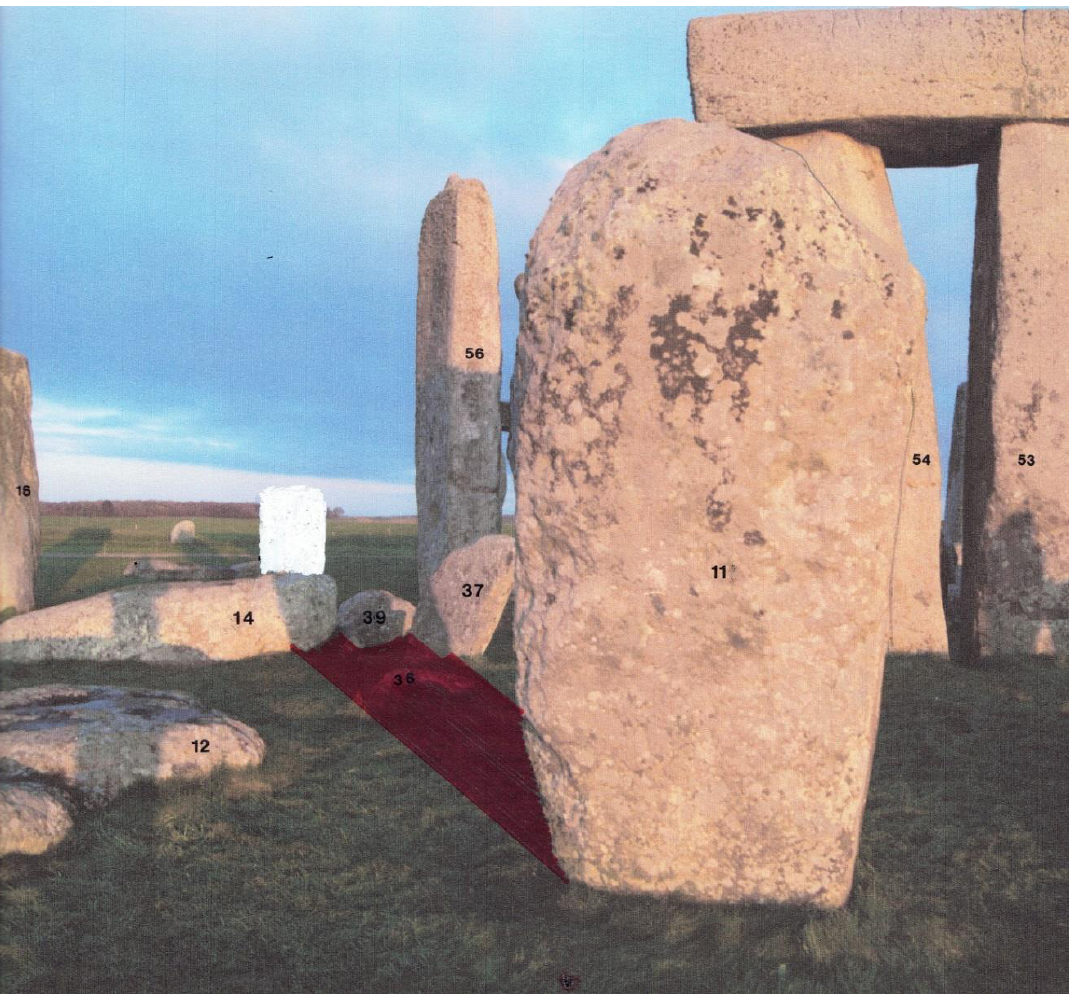
Figure 12. To help understand Figure 11 the photographed sunrise shadow of sarsen Stone 11 has been darkened and the position of a standing stone inserted at the place where Bluestone 40 is in the ground. It is shown white for emphasis and clarity. The big sarsen Stone 14 has fallen from the left and lies across Bluestone 38 which may itself be part of a once-single bluestone because both 38 and 40 are rhyolite ignimbrite, the only examples known at Stonehenge. The shadow of Stone 11 crosses the fallen Bluestone 36, grazes the upright Bluestone 37, and then crosses the broken Bluestone 38 (most of which is beneath Stone 14) and the fragment numbered Bluestone 39. Bluestone 36 lies prone has fallen from the right (compare with the plan in Figure 7 and the photograph of Figure 11). Note that this photograph was taken six days after the solstice and a few minutes later than sunrise, so this situation roughly corresponds to the position of shadows for 21 December just after the solstice sunrise. (Author’s